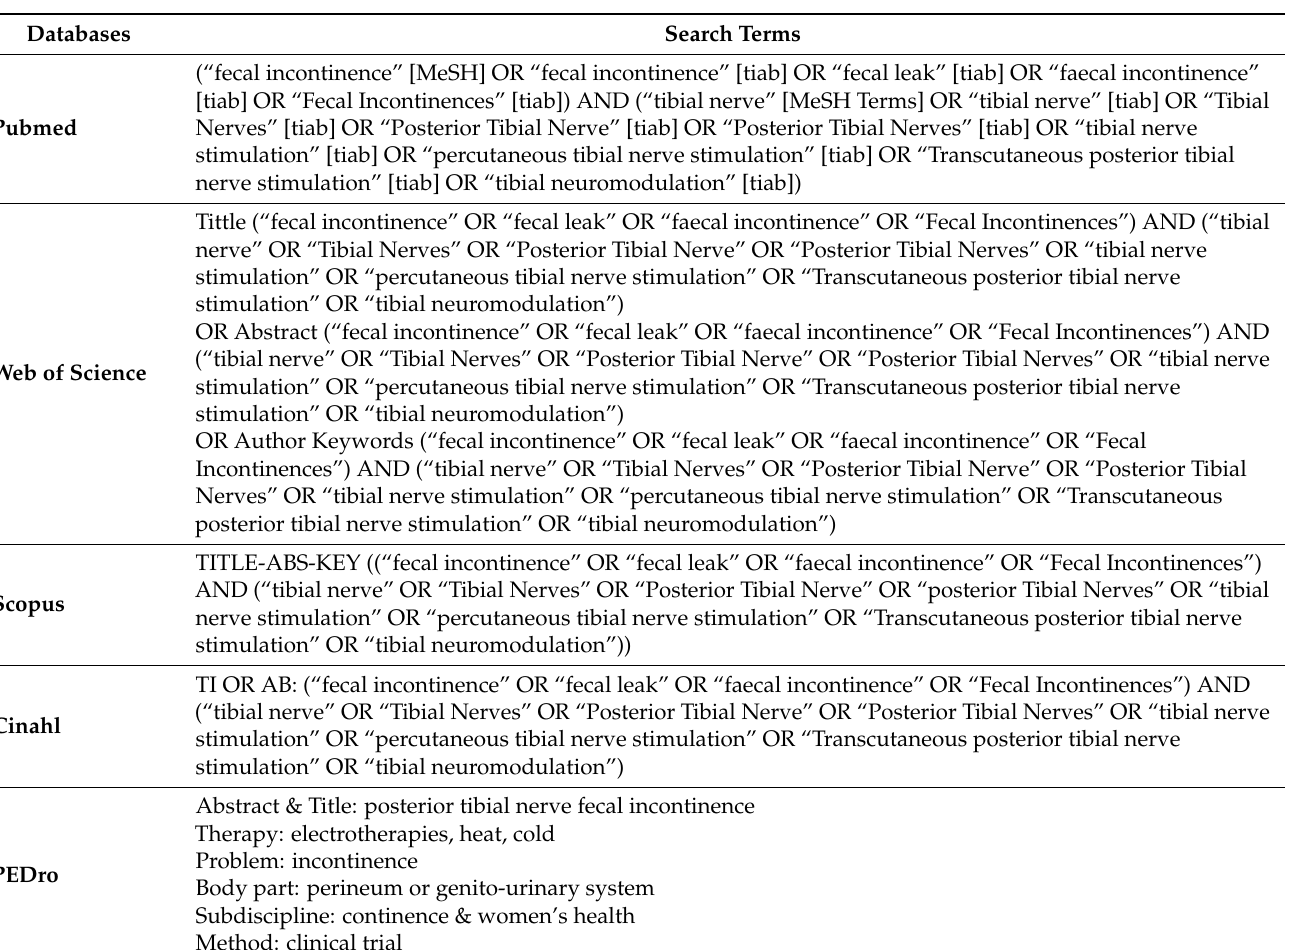
Table 1. Databases and search